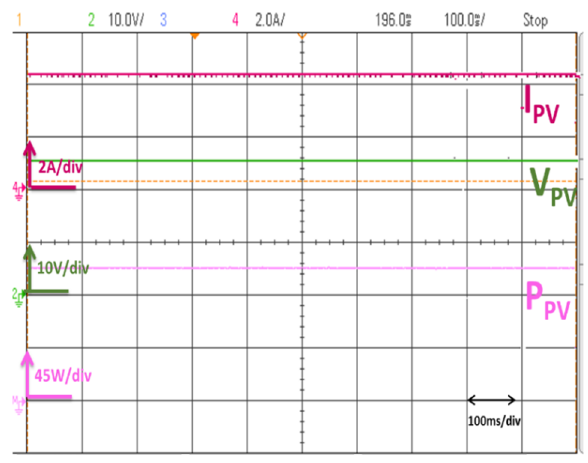
Figure 13. PV voltage current and power for the proposed Fixed-Frequency predictive MPPT (P max = 115 W) (Ch2 (green) is PV voltage, Ch4 (pink line) is the PV current), the PV extracted power (lavender line).